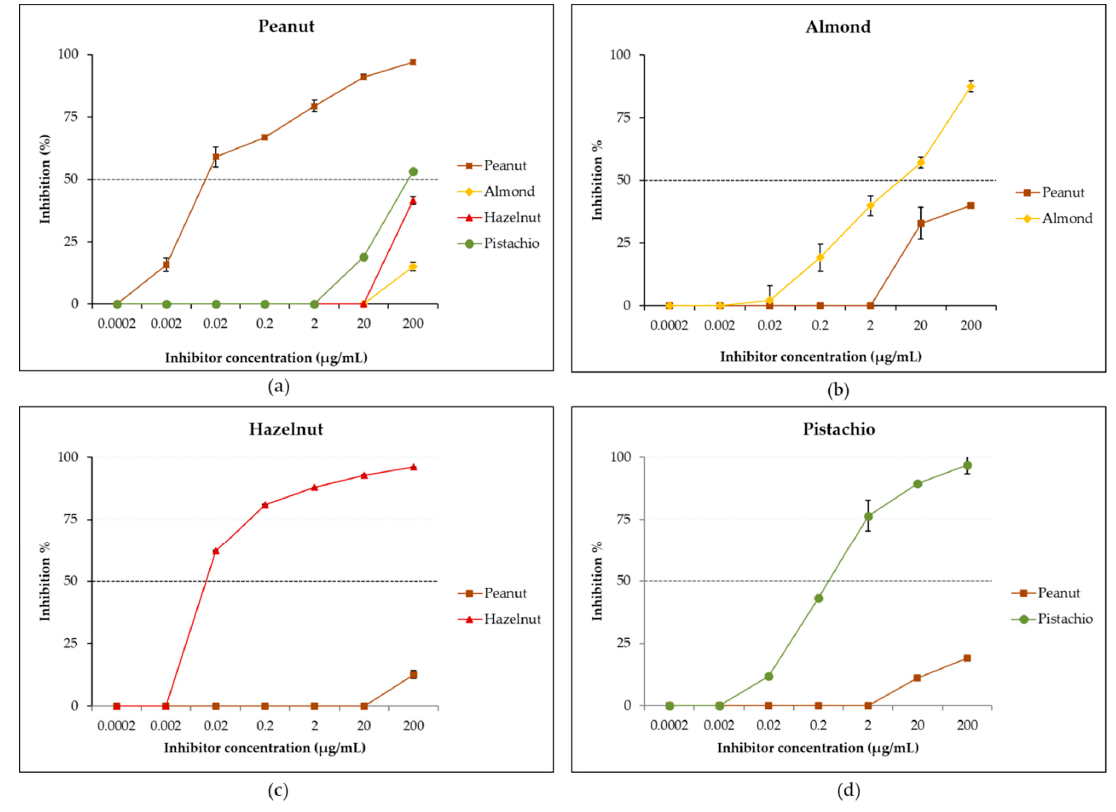
Figure 4. Reciprocal IgE inhibition ELISAs with peanut ( a ), almond ( b ), hazelnut ( c ) and pistachio ( d ) extracts adsorbed to the solid phase with inhibitor protein concentrations from 0.0002 to 200 µg/mL. The dashed horizontal line intercepts the inhibition curves at the median inhibitory concentration (IC 50 ).